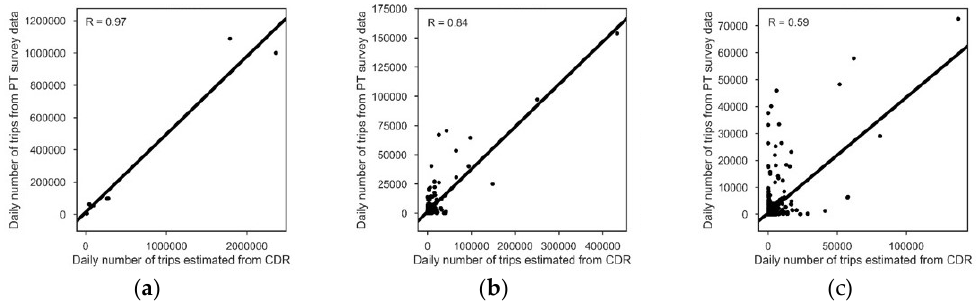
Figure 20. Comparison of daily trip volumes obtained from CDR and person-trip survey at respective TAZ levels: ( a ) A TAZ, ( b ) B TAZ, and ( c ) C TAZ.